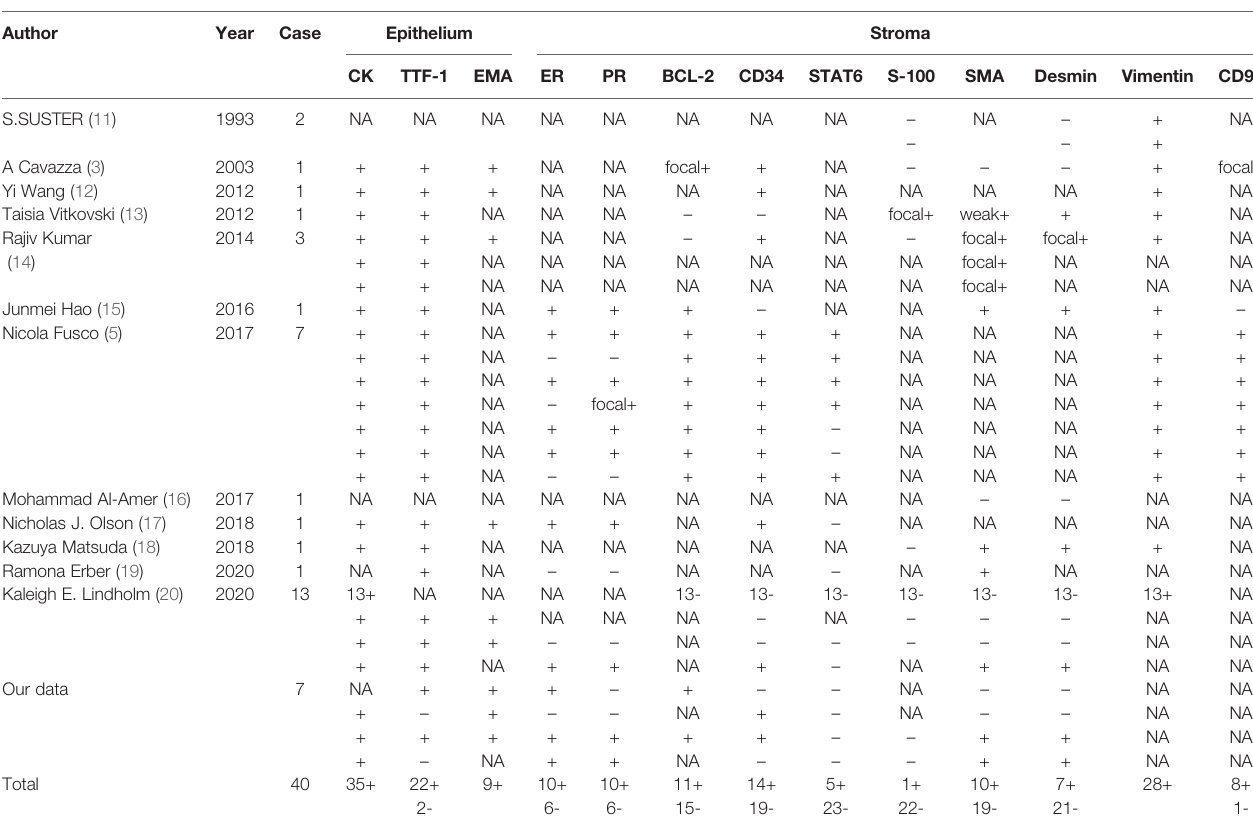
TABLE 2 | Integrating the immunophenotypes of pulmonary adeno fi